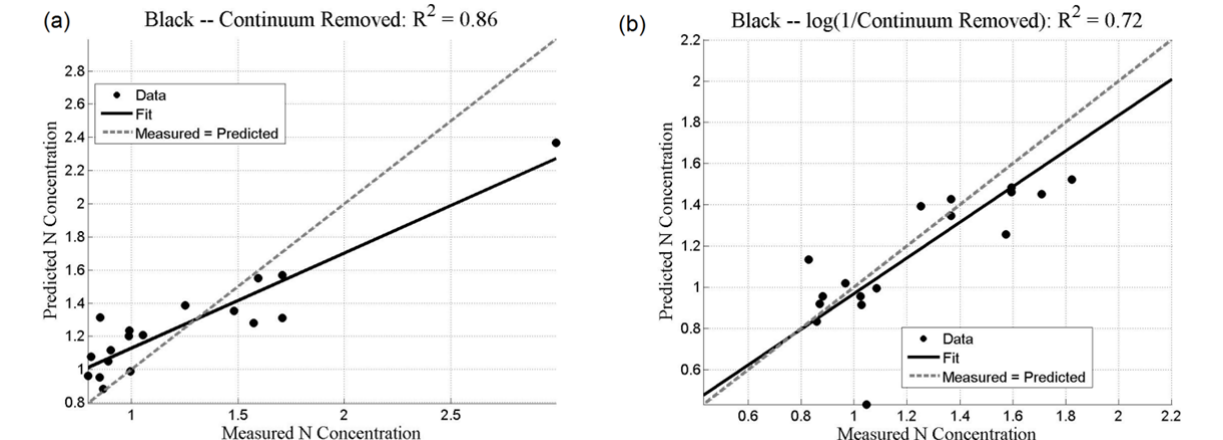
Figure 9. Artificial Neural Network (ANN) testing results for black mangrove reflectance. Dashed line indicates measured concentration = predicted concentration ( i.e. , r 2 =